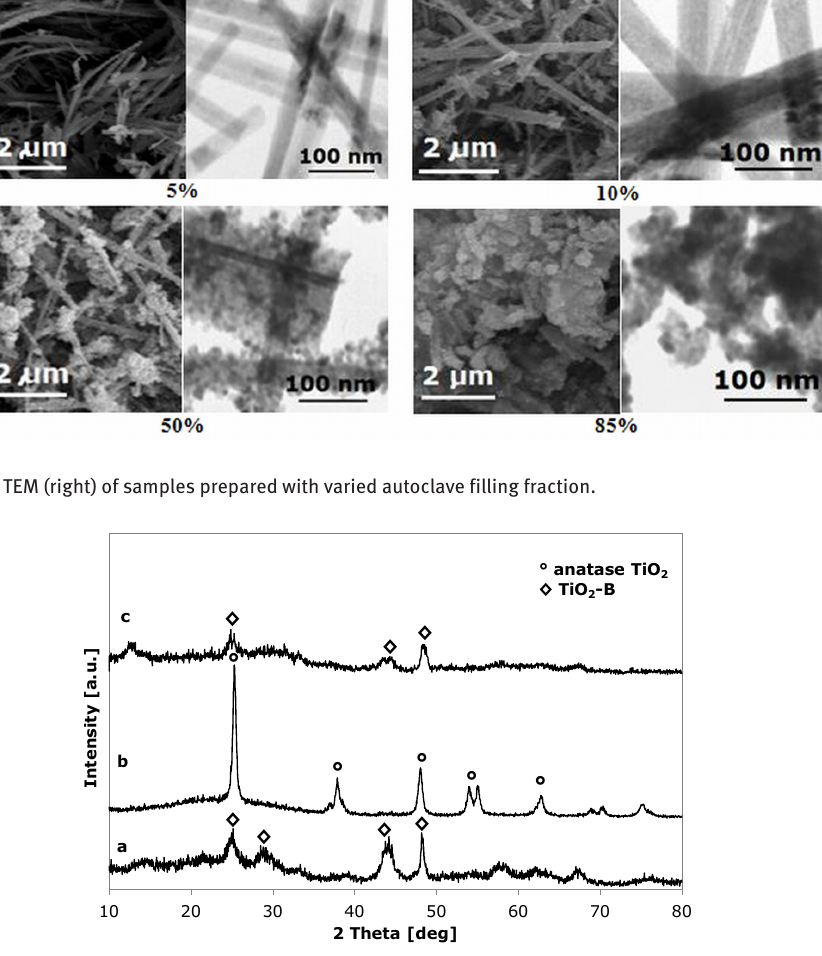
P25; (b) as synthesized TiO 2